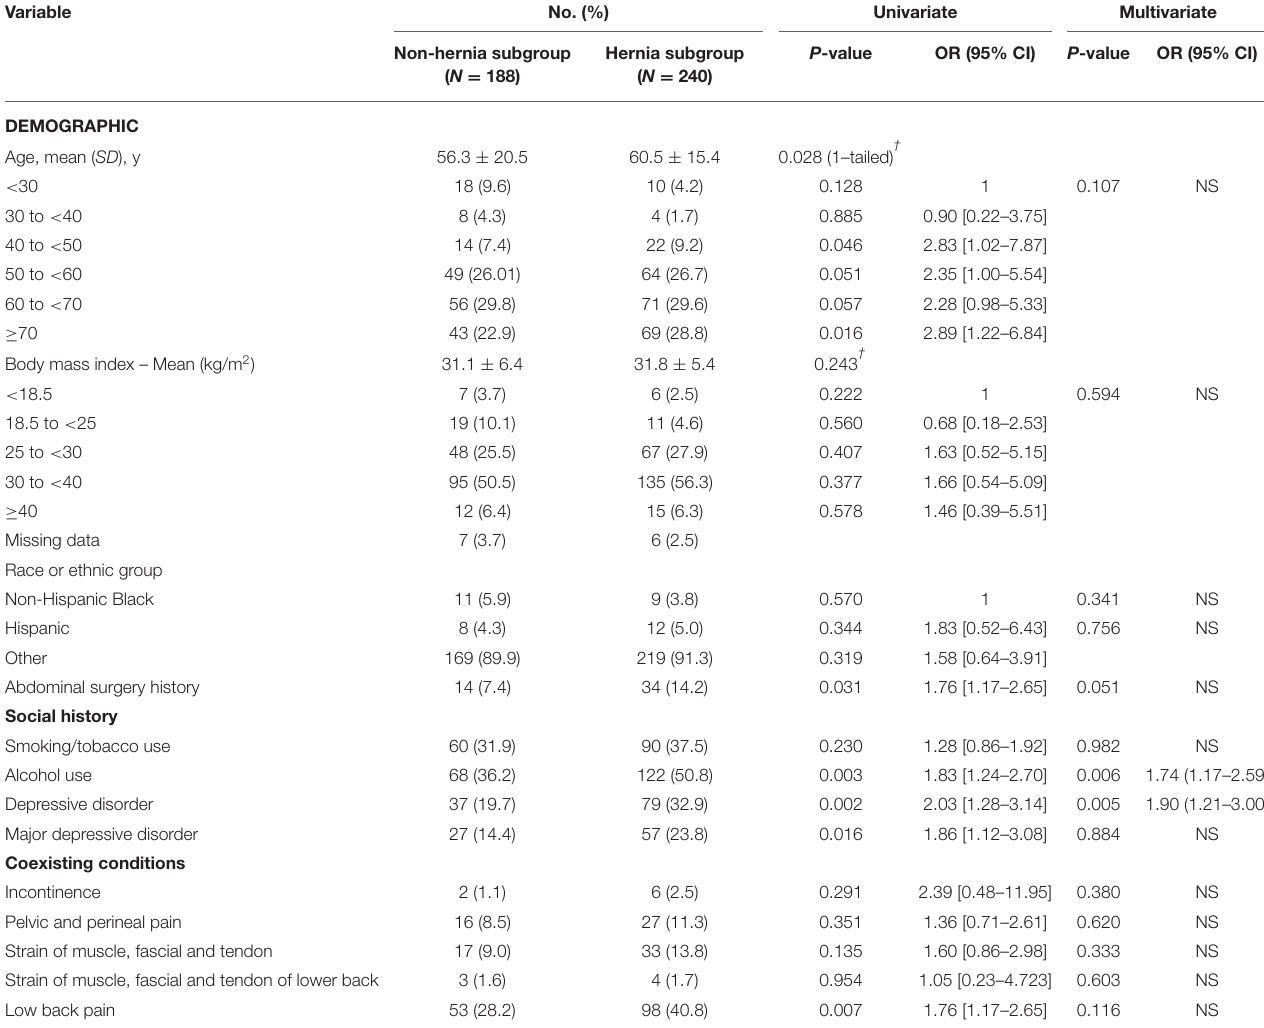
TABLE 4 | Characteristics of RAD men with or without hernia. Variable No. (%) Univariate